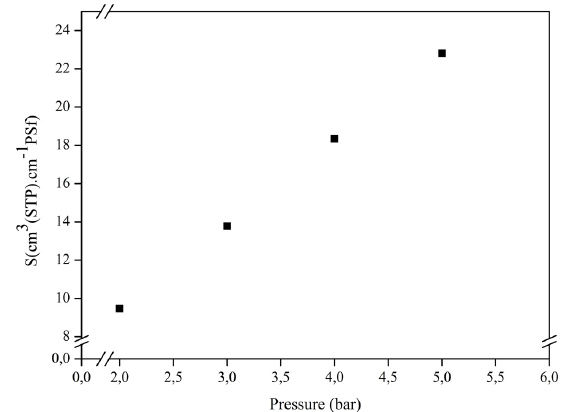
Figure 7 - Diffusivity coefficients predicted by Equations 7 and